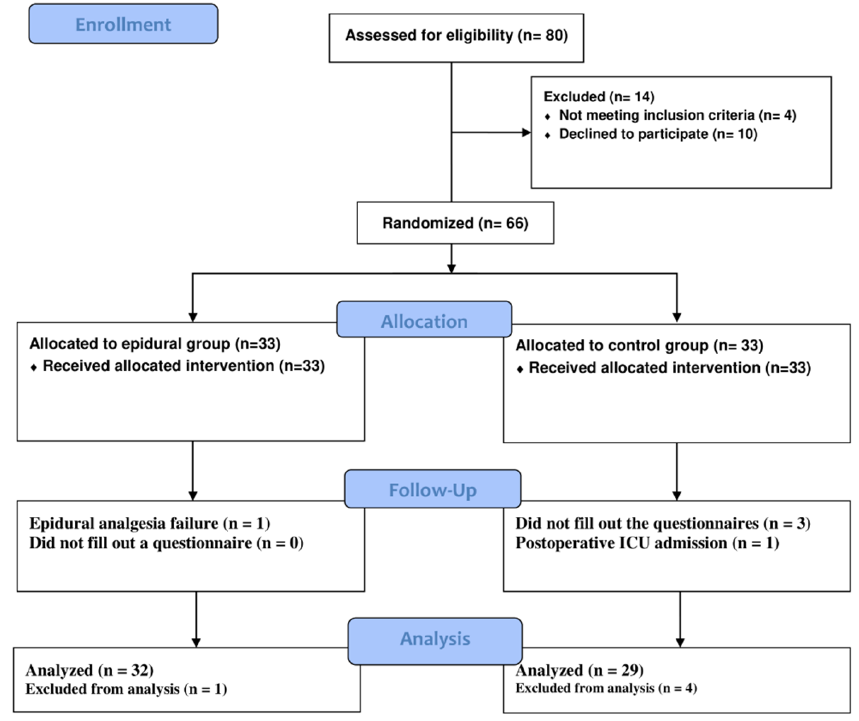
Figure 1. Flow diagram of the participants of the study.